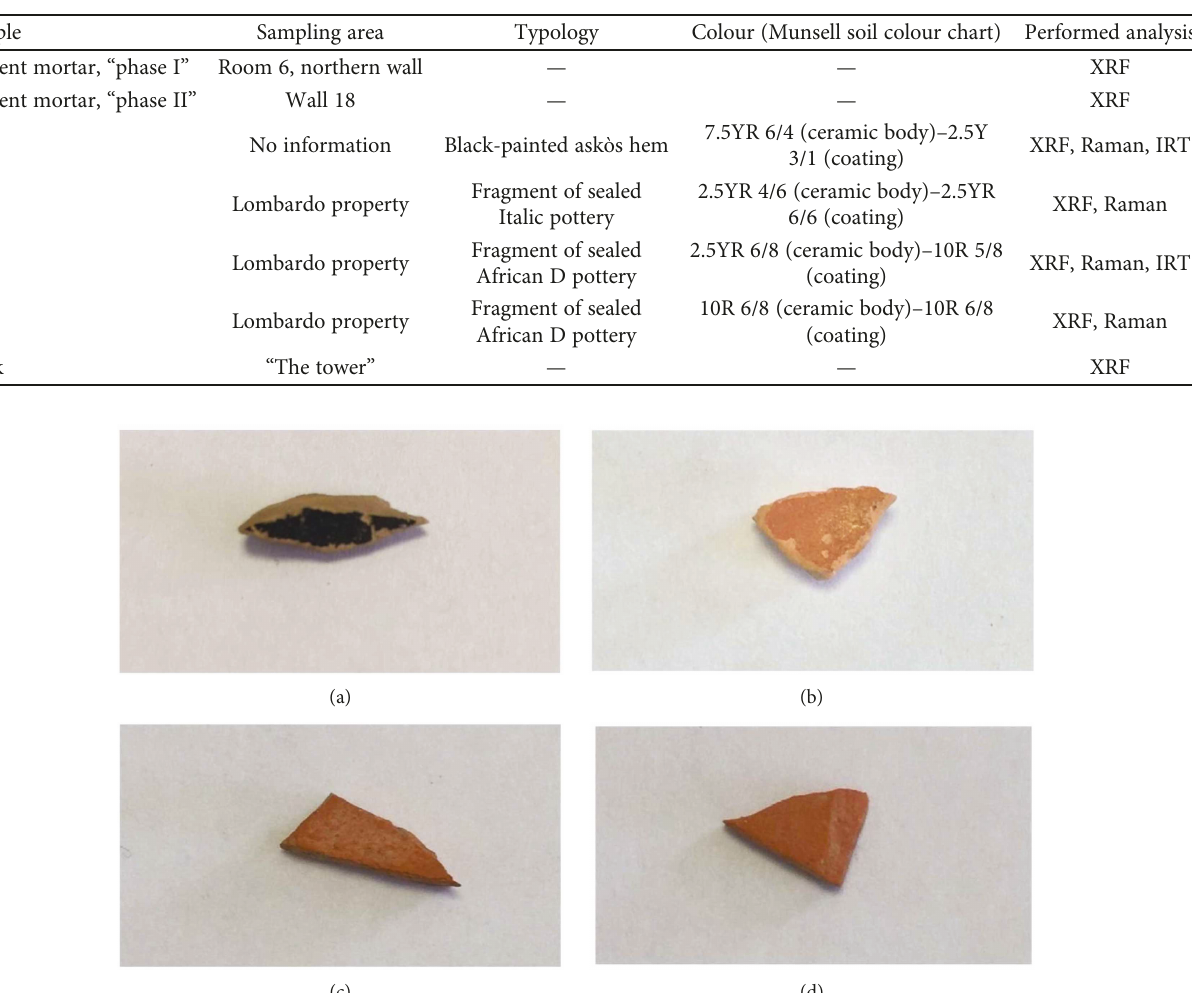
Table 1: Information relative to the investigated samples from the archaeological site of Scifì.